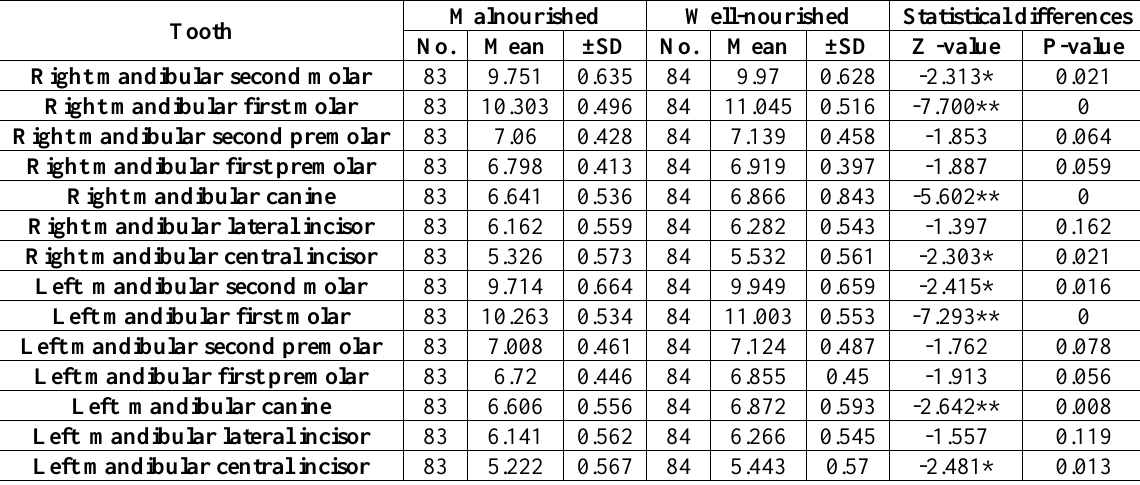
Table 2: Measurement of mesiodistal diameters (mm) of mandibular teeth in malnourished and well-nourished group among adolescent aged 15 years by gender Tooth